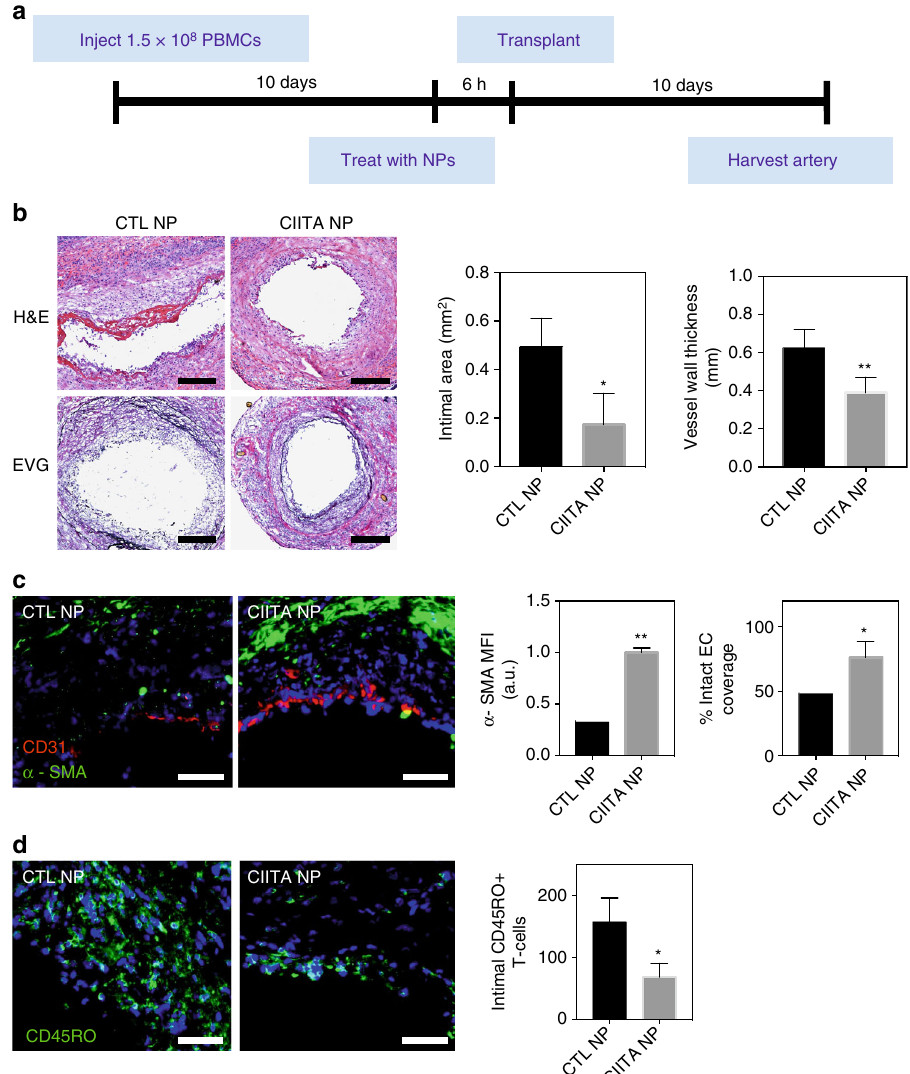
Fig. 7 NPs reduce intimal expansion and T-cell in fi ltration in transplanted human arterial allograft. a Human arteries were pretreated with siRNA-loaded nanoparticles for 6 h and transplanted into SCID/bg mice previously reconstituted with 1.5 × 10 8 allogeneic human PBMCs. After 10 days, arteries were harvested, sectioned, and stained. b CIITA nanoparticle pretreated arteries ( n = 4) or CTL nanoparticle pretreated arteries ( n = 4) were sectioned and stained using H&E and EVG. Intimal area and vessel wall thickness were quanti fi ed using ImageJ ( scale bar : 200 μ m). c Artery sections were stained for human α -SMA ( green ), human CD31 ( red ), and DAPI ( blue ). α -SMA and endothelial cell coverage was quanti fi ed using ImageJ ( scale bar : 100 μ m). d Artery sections were stained for CD45RO ( green ) and DAPI ( blue ). Total number of CD45RO + cells in the intima (per cross-section) was quanti fi ed from fl uorescent images ( scale bar : 100 μ m). Data shown is mean ± SD, * p < 0.05, ** p < 0.01, by student ’ s t-t min to obtain a cell pellet. Isolated cells were stained for CD31 and gated for CD31 perfused within 2h. Umbilical veins were connected to the perfusion system via + cells on the fl ow cytometer, prior to quanti fi cation of fl uorescent nanoparticle barbed luers (Macmaster) and platinum-cured silicone tubing (Cole Parmer). uptake. Veins were submersed in M199 medium and kept at 37 °C during the experiment. Nanoparticles (0.1 mg mL − 1 ), resuspended in M199 medium, were perfused through the umbilical vein using a Low Flow Rate Peristaltic Pump (Langer Instruments). The fl ow rate was adjusted between 0 and 128 mLmin − 1 (shear stress 0 – 0.8dynes cm − 2 ) and the pressure was maintained at 5 – 10 mmHg. Umbilical veins were perfused in this solution for 6h. Percent of endothelial cell retention post perfusion was calculated as follows: CD31+ endothelial cell linear coverage post perfusion/ CD31+ endothelial cell linear coverage pre perfusion x 100%. To collect cells for culture, fl ow cytometry, and /quantitative reverse transcription-PCR, HUVECs were isolated from umbilical veins 41 . In brief, after nanoparticle perfusion, umbilical veins were washed with HBSS x 3 and fi lled with 10mL of 0.1% collagenase type II (Worthington). Veins were tied on both sides and incubated in a beaker of 200 mL Dulbecco's phosphate-buffered saline (DPBS) for 15 min at 37 °C. After incubation, veins were fl ushed with 20mL of HBSS to collect dissociated endothelial cells. The cell solution was centrifuged at 250× g x10 all, 1.5 ×10 6 CFSE labeled CD4+ memory T cells were added to 1× 10 5 endothelial